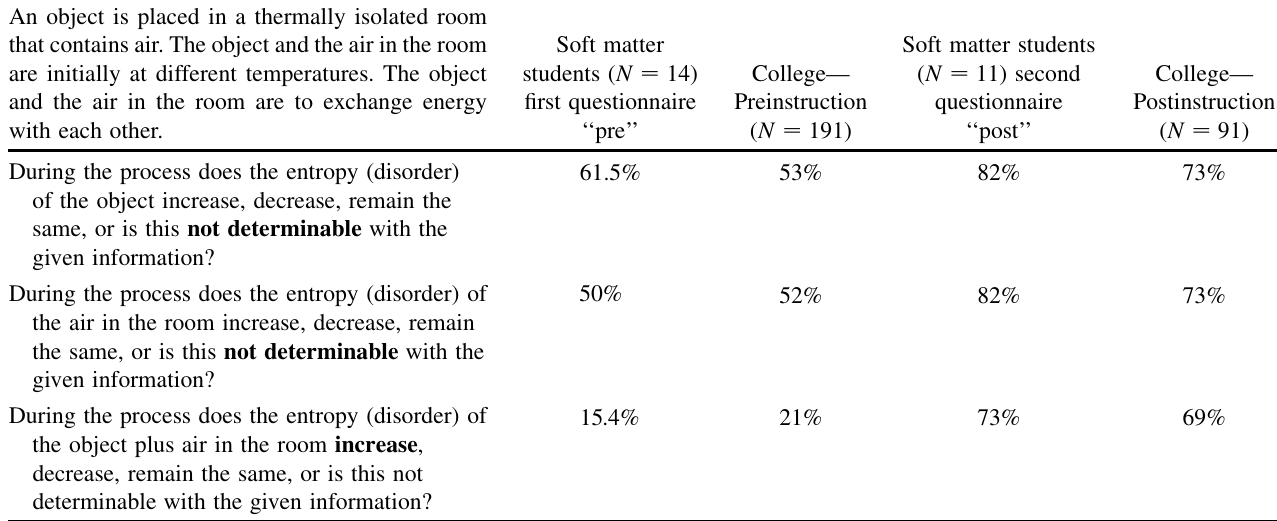
TABLE I. A comparison of student correct answers to the thermal equilibration problem, expected answers are in bold. An object is placed in a thermally isolated room that contains air. The object and the air in the room are initially at different temperatures. The object and the air in the room are to exchange energy with each